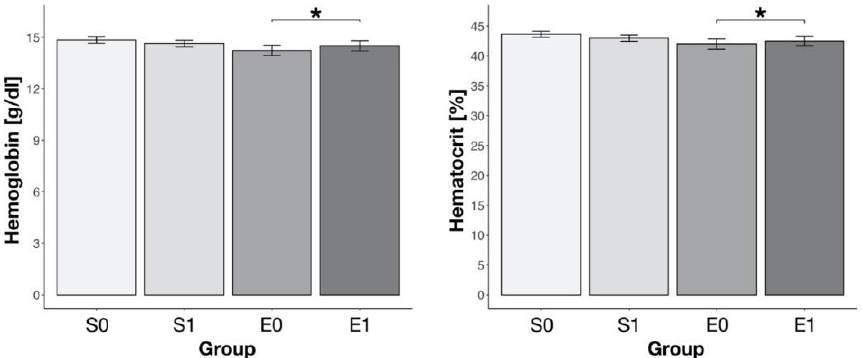
Figure 5. The hemoglobin concentration and hematocrit in strength (S) and endurance (E) athletes according to the use of injections (0–without injection; 1–after injection), * p < 0.05.